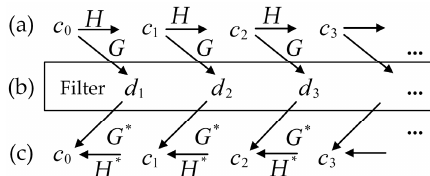
Figure 3. The flow of wavelet decomposition, threshold processing, and reconstruction. The data processing steps in this figure are as follows: ( a ) Decompose the well-testing data into multi-layers by Symlets wavelet. The decomposition is carried out only for low-frequency parts each time; 0 c to 3 c are the frequency details of the signal with different decomposition levels. The level is determined as needed. ( b ) Threshold process the high frequency decomposition coefficient d of c to filter out the noise; d can be calculated according to Formula (1). ( c ) Do wavelet reconstruction using denoised